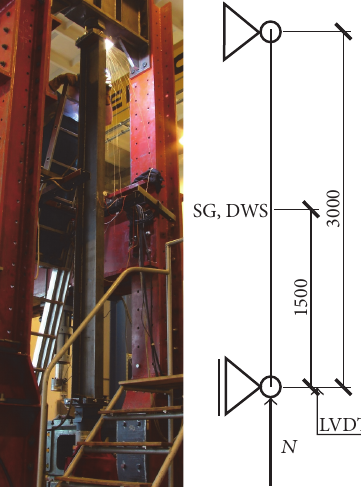
Figure 1: Column specimen strengthened under load in the test set-